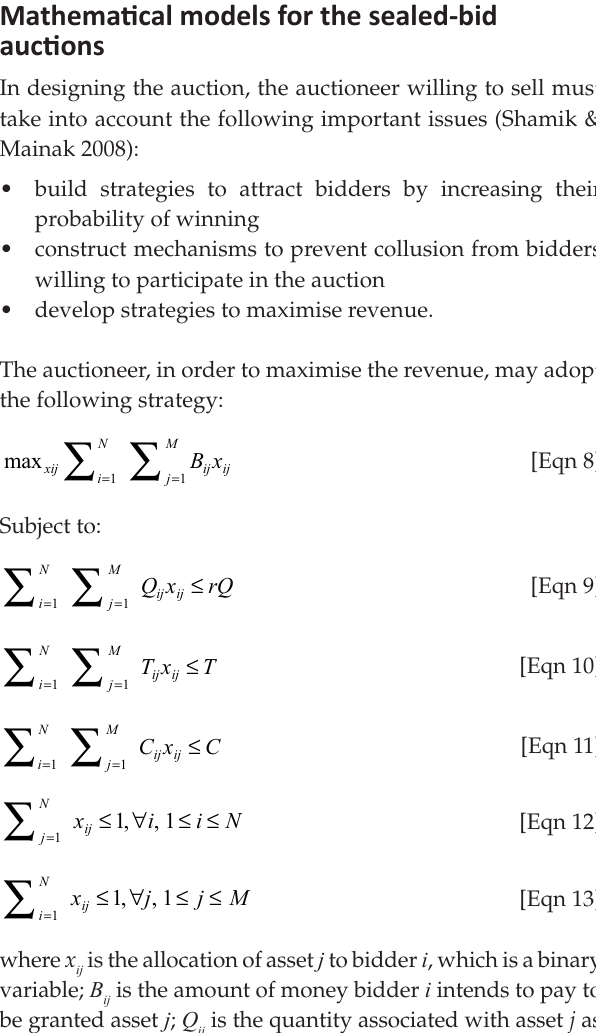
( t ) (asset bidding 5), t ∈ [ t 5